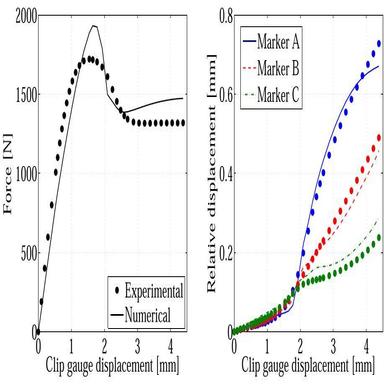
Mechanical response using VGM model for the best fitting of necking kinematic f d .